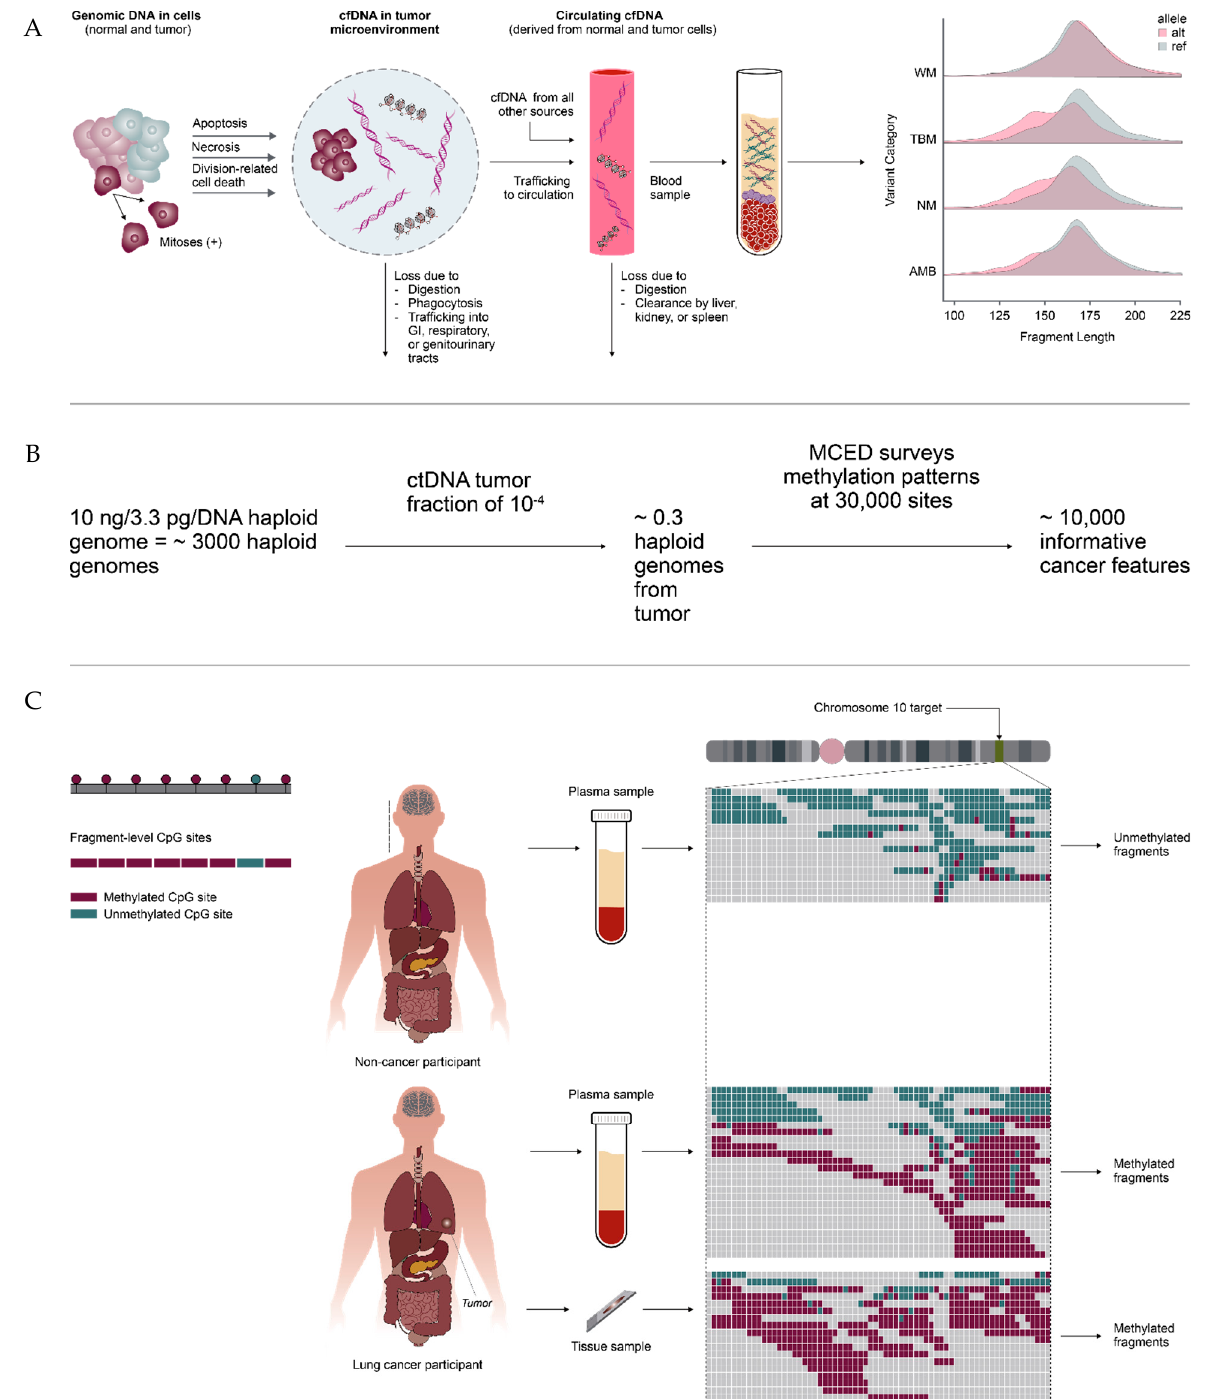
Figure 1. ( A ) cfDNA is composed of fragmented DNA, not individual genomes. ( B ) MCED surveys many sites enabling detection at or below a ctDNA tumor fraction of 10 − 4 from one blood tube. ( C ) Each MCED classifier feature covers multiple bases, typically with reinforcing methylation patterns across multiple CpGs.